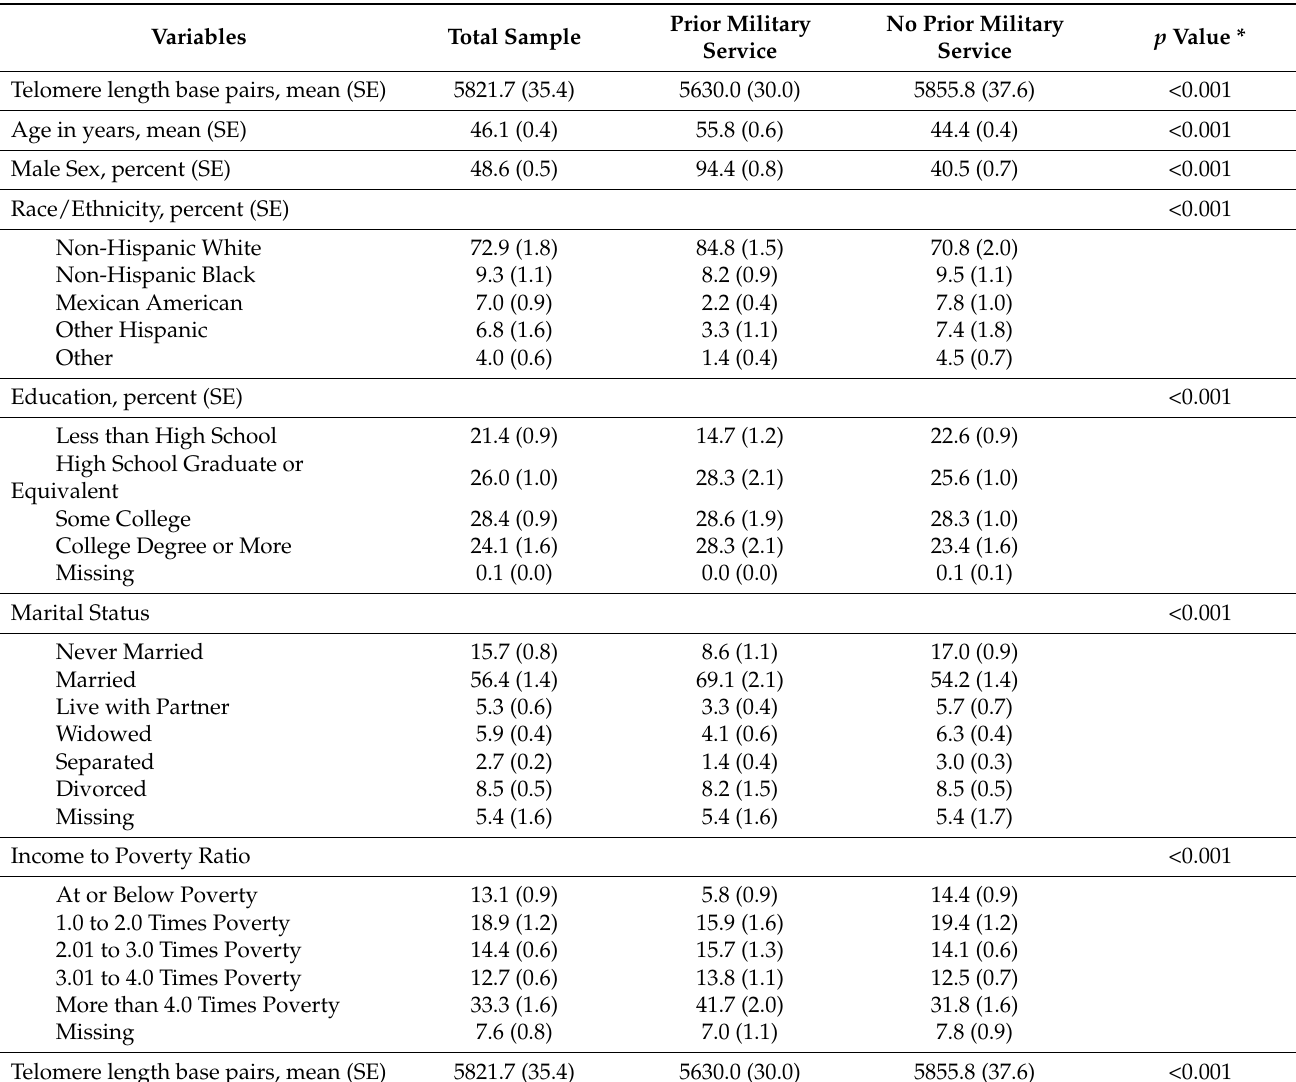
Table 1. Weighted demographic and socioeconomic characteristics ( n =